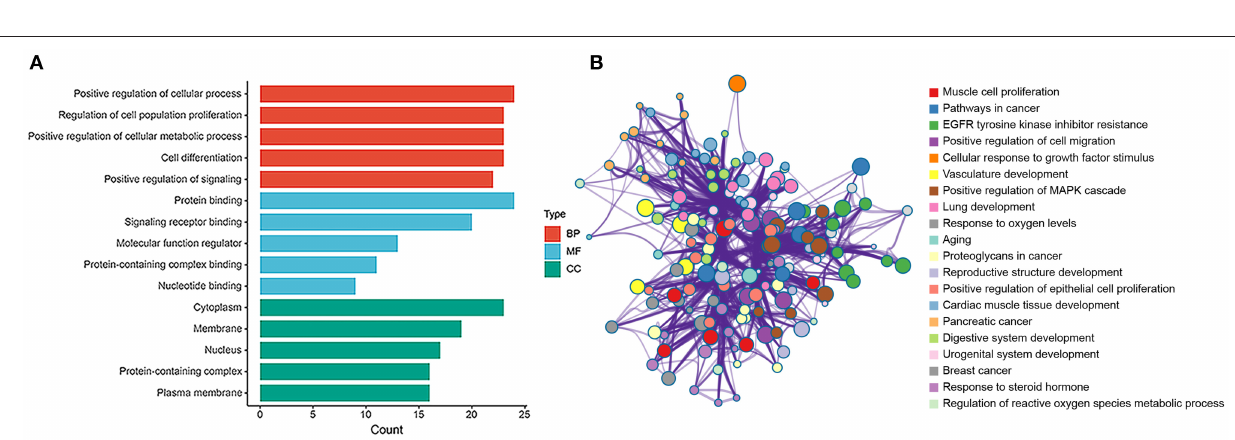
FIGURE 7 | GO and enrichment network of top 30 hub genes between SHR and WKY rat aorta. (A) Top 5 GO enriched terms were analyzed in rat aorta for biological process (BP), cellular component (CC), and molecular function (MF), respectively. (B) The enrichment network of top 30 hub genes was identified in rat aorta. Nodes represent functions enriched for an annotated ontology term and node size indicates the number of genes that fall into that term. GO, gene ontology; WKY, Wistar-Kyoto; SHR spontaneously hypertensive rat; EGFR, epidermal growth factor receptor; MAPK, mitogen-activated protein